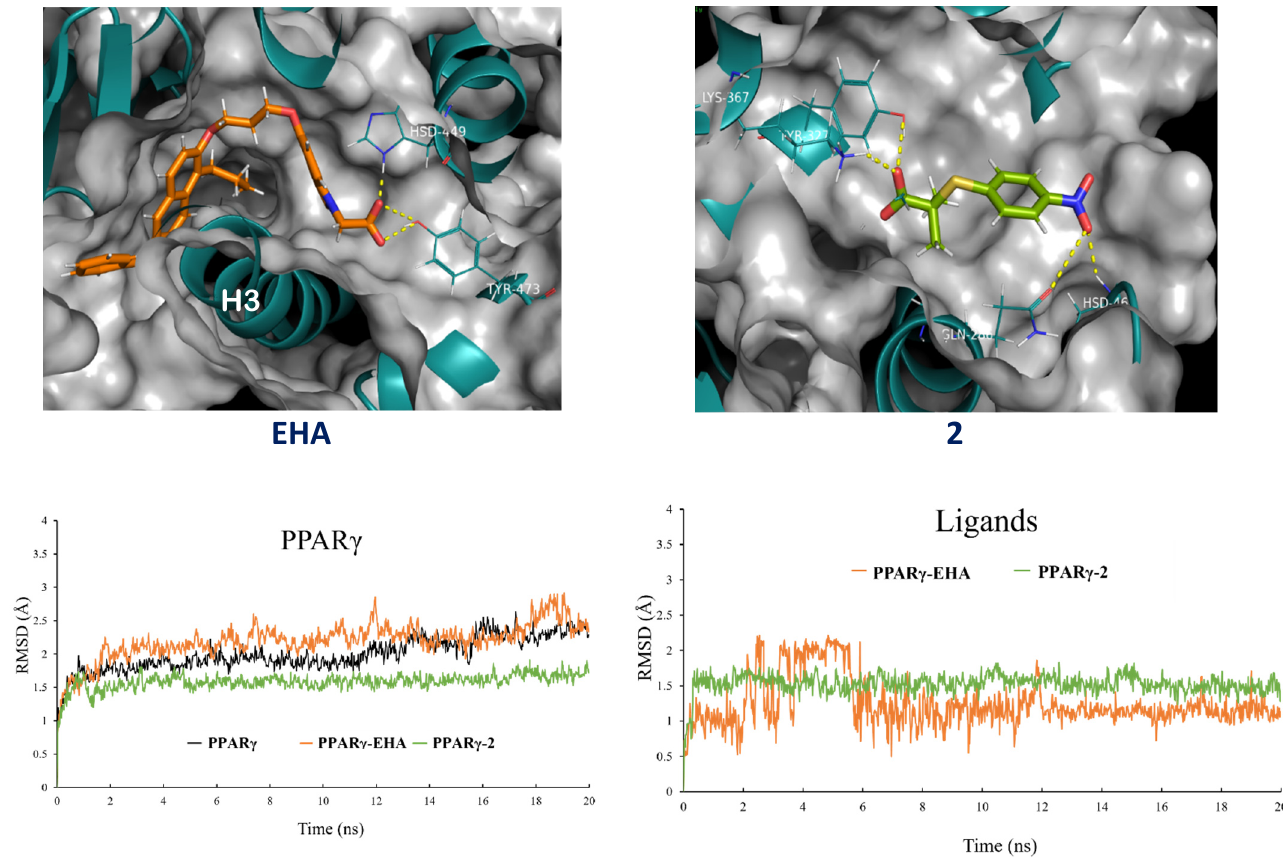
Figure 7. Hydrogen-bonding network of EHA (orange) and nitrocompound 2 (green) in the binding pocket of PPAR γ (PDB code: 2F4B); RMSD of protein and ligands.